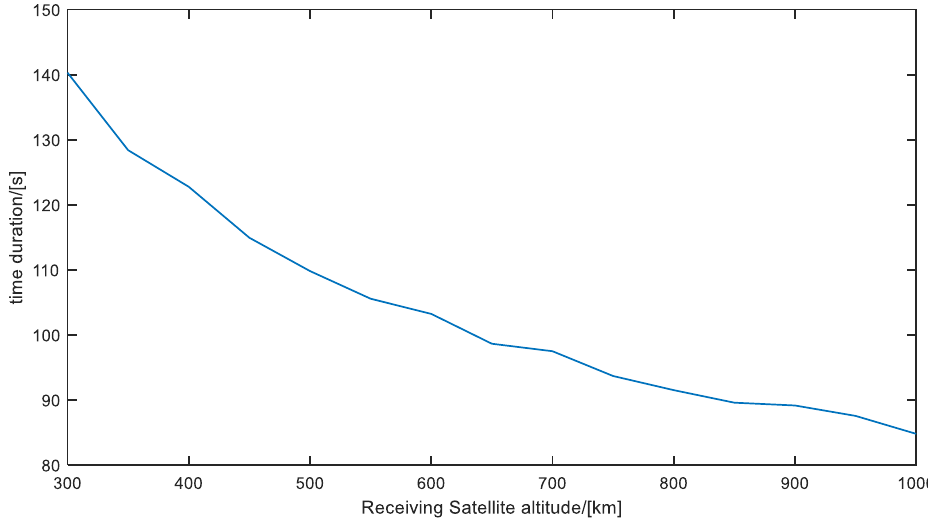
Figure 2. Variation in occultation duration with satellite altitude.